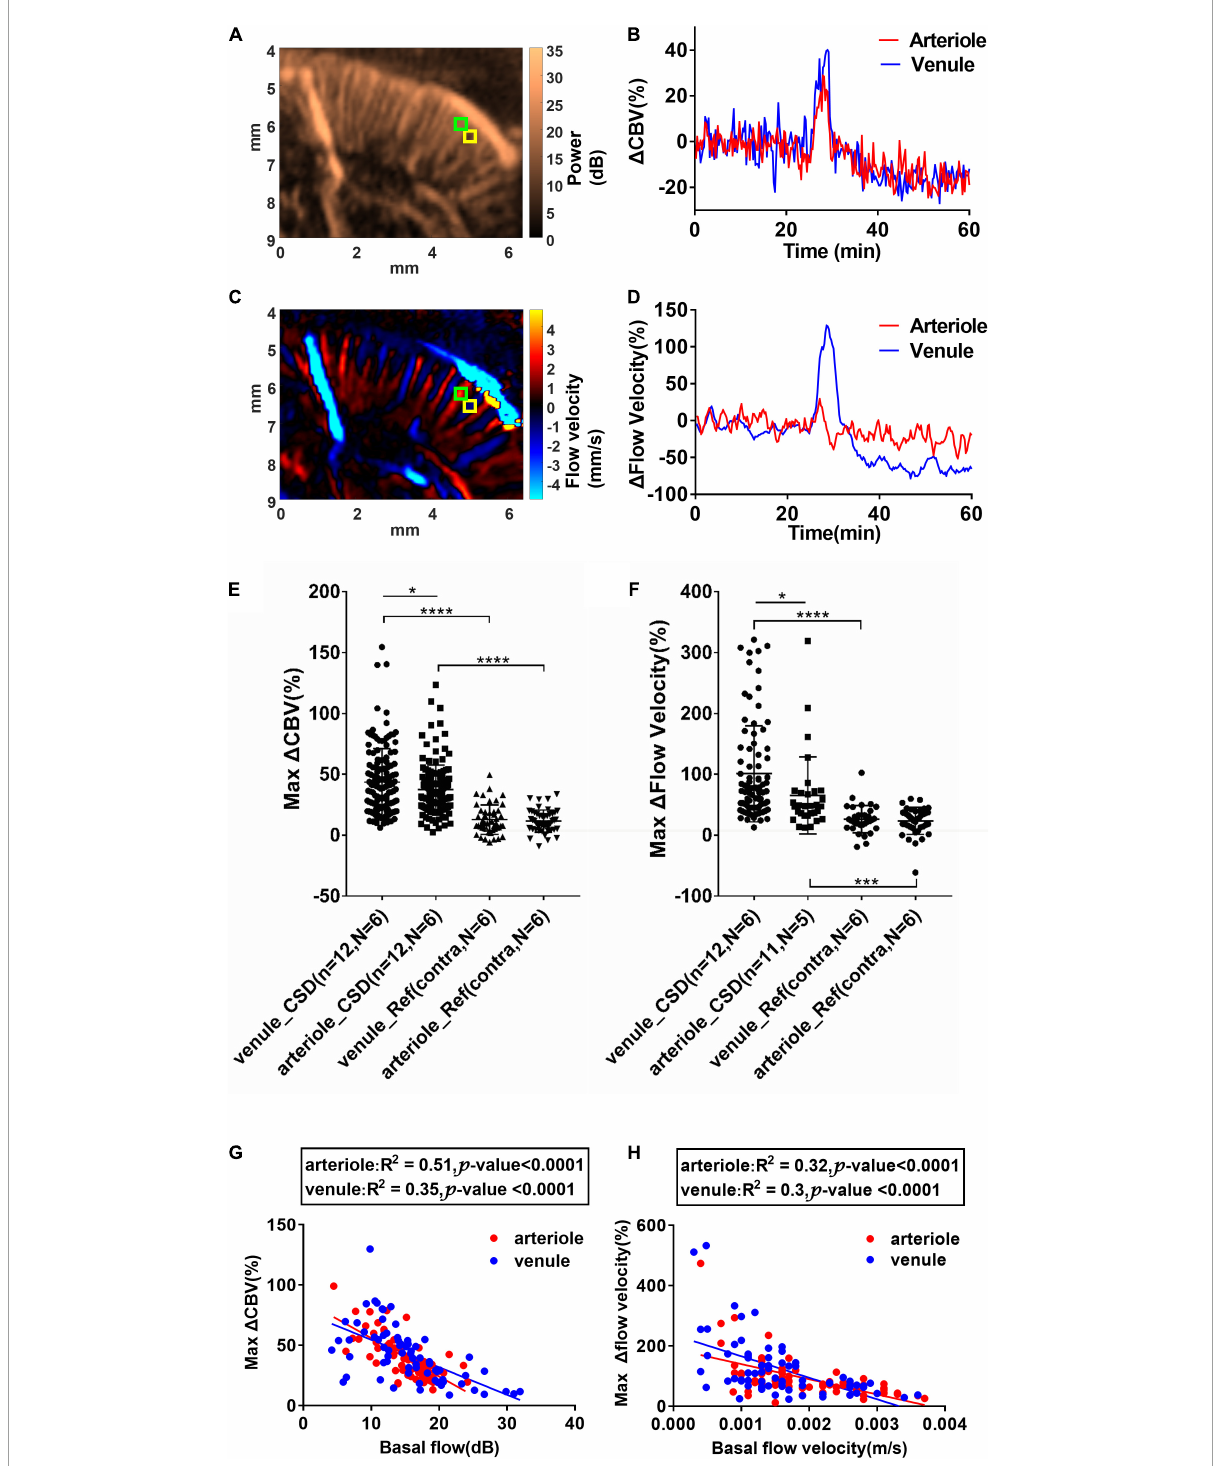
FIGURE5 Cortical spreading depolarization-induced CBV and flow velocity changes in single penetrating vessels. (A) Power Doppler and (C) color Doppler images showing CBF in penetrating arterioles and venules. Blood flows toward the transducer and away from the transducer are labeled as blue and red, respectively. (B) (cid:49) CBV and (D) (cid:49) flow velocity changes in the single penetrating arteriole and venule as indicated in ROIs in (A) and (C) (arteriole: Green ROI and venule: Yellow ROI). Summarized data of maximum (cid:49) CBV and maximum (cid:49) flow velocity in single penetrating vessels during CSD. (E) Maximum (cid:49) CBV in single arterioles and venules in the ipsilateral and contralateral side of KCl stimulation.